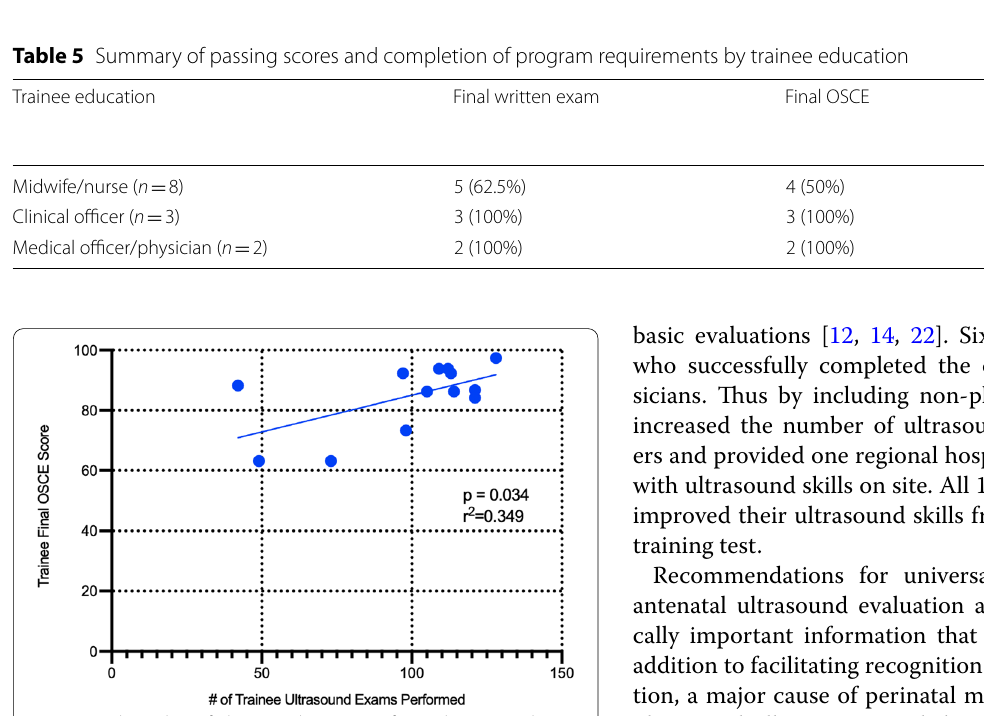
Fig. 2 Total number of ultrasound exams performed compared